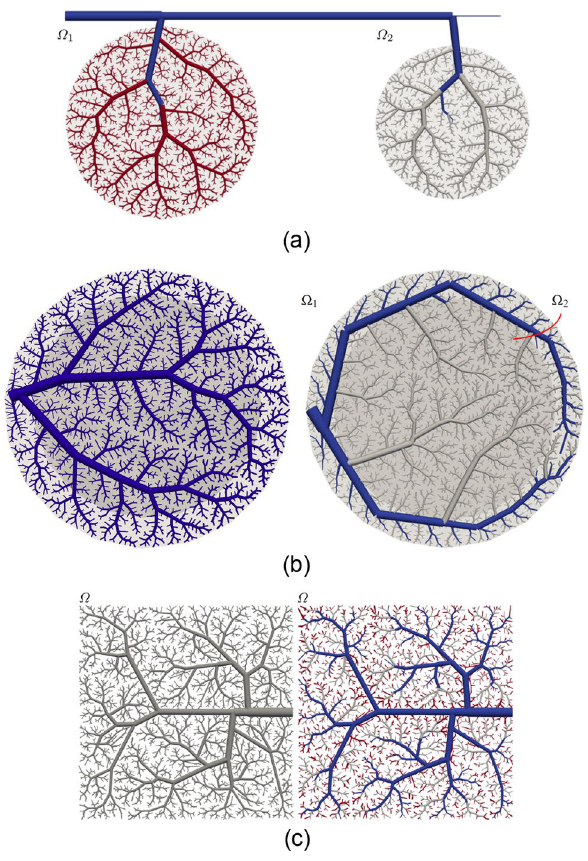
Figure 2. Different vascular architectures obtained using the staged growth paradigm. ( a ) Sequential vascular growth: blue vessels correspond to a pre-defined existing vascularisation T 0 , while red and grey ones correspond to trees T 1 and T 2 , generated at stages S 1 and S 2 . ( b ) Hierarchical vascular growth: (left) vascularisation obtained with a standard CCO algorithm with parameters P geo and P opt ; (right) the first stage of the network is T 1 , grown in the annulus subdomain (cid:31) 1 (light grey), while the second stage is T 2 , the inner circular subdomain (cid:31) 2 (dark grey). ( c ) Scale-specific vascular growth: (left) vascularisation obtained with a standard CCO algorithm with δ = 0.7 ; (right) vascularisation using three stages with with δ = 0.7 , 0.5 and 0.2 for T 1 (blue vessels), T 2 (grey vessels) and T 3 (red vessels), respectively. Images generated with ParaView version 5.4 available at https ://www.parav